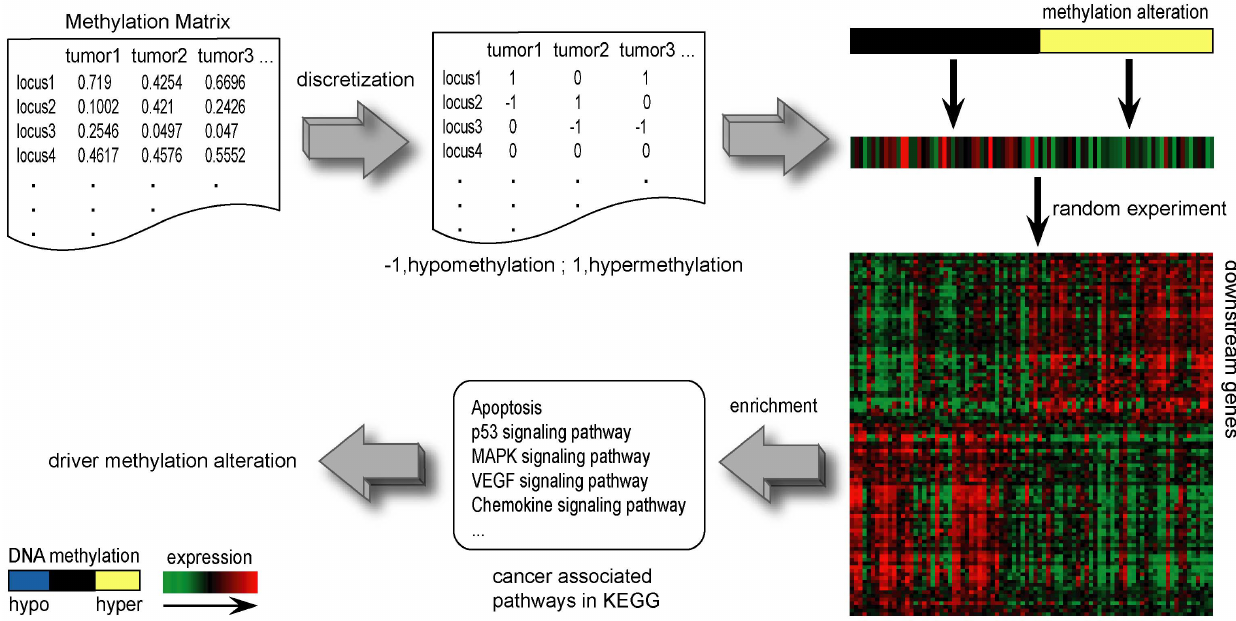
Figure 1. Schematic overview of the approach. Methylation matrix of continuous beta values is transformed into a discrete profile by comparing with the methylation profiles of normal samples by discretization (1 denotes hypermethylation, 2 1 denotes hypomethylation and 0 denotes no differential methylation). Identification of driver alteration required following three conditions. Firstly, for each locus, if its gene expression was significantly down- or up-regulated in hyper- or hypomethylated cancer samples comparing with the cancer samples which had no differential methylation at this locus (T-test, FDR , 0.05), it is retained for follow analysis. We showed the hypermethylated locus (labeled with yellow) as an example. Secondly, the methylation alterations which influence the expression of significantly more downstream genes were selected (see Methods). Thirdly, downstream genes of a driver methylation alteration should be enriched in at least one of the cancer-associated pathways.